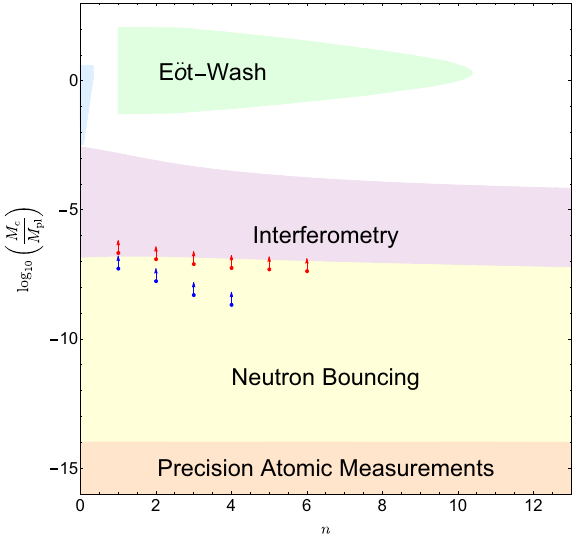
Fig. 6 Current bounds on the parameters n and M c when Λ is fixed to the dark energy scale Λ DE and n > 0. The regions excluded by each specific test are indicated in the figure. The blue region corresponds to astrophysical tests, which includes both Cepheid and rotation curve tests. The blue and red arrows indicate the lower bounds coming from the neutron interferometry experiments of Lemmel et al. (2015) and Li et al. (2016) respectively